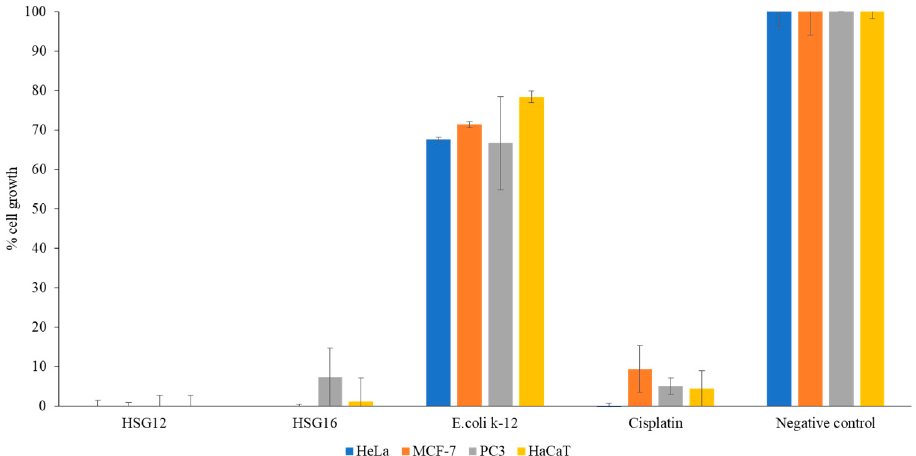
Figure 3. The growth inhibition effect of effective conditioned media (10 μ g/mL) prepared from bacteria isolated from the gastrointestinal tract sample of scorpion, H. spinifer , against HeLa cells as described in the Materials and Methods. The results represent mean ± standard error of two sets of experiments performed in duplicate for HeLa cells.